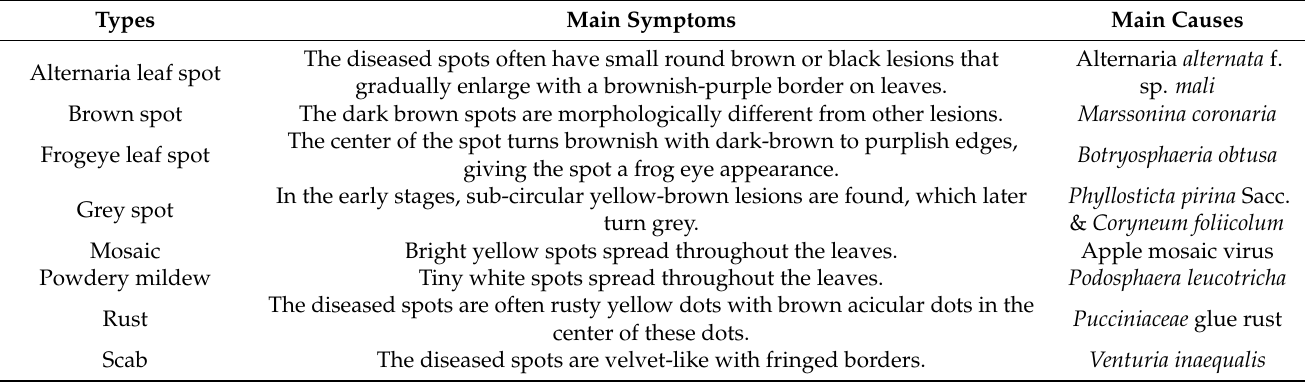
Table 1. Main symptoms and causes of the eight types of